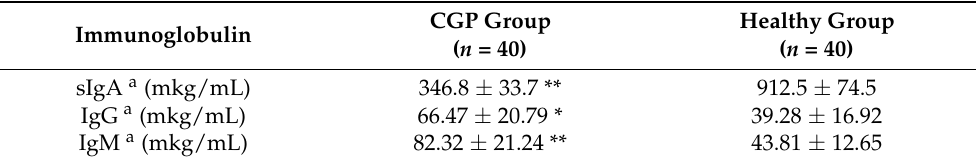
Table 6. Concentration of immunoglobulins in saliva in patients with chronic generalized periodontitis.